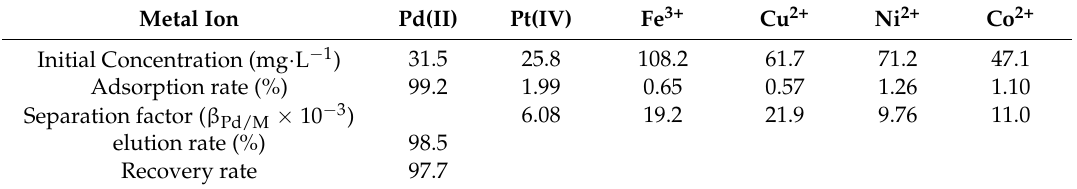
Table 5. Adsorption and separation of palladium from leaching liquor of Cu–Ni sulfide ores. Metal